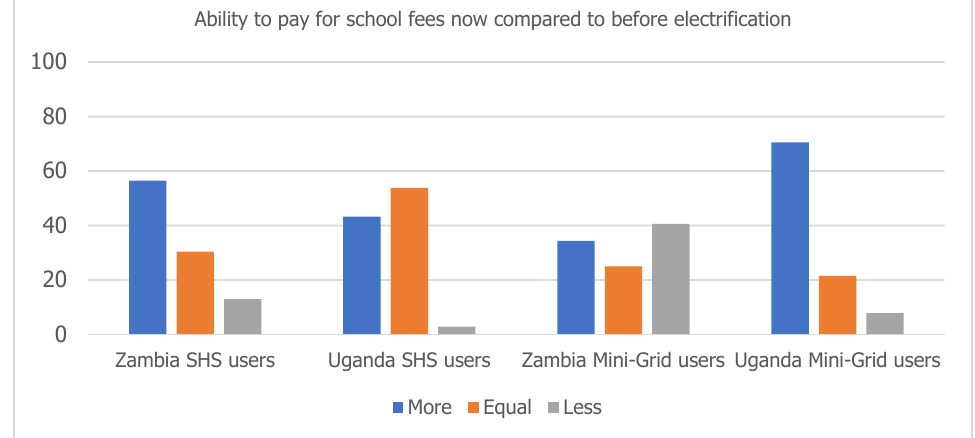
Figure A5. Desire for productive energy use in Uganda and Zambia (Responses in %).